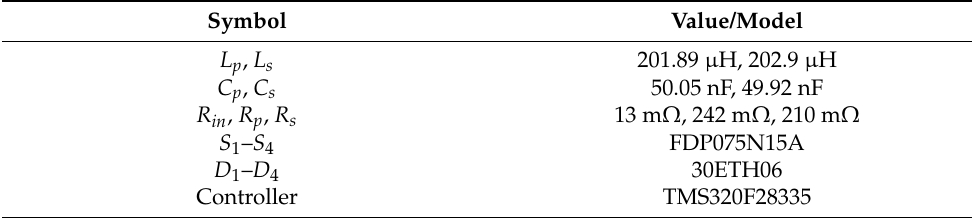
Table 1. Parameter values and components of the experimental